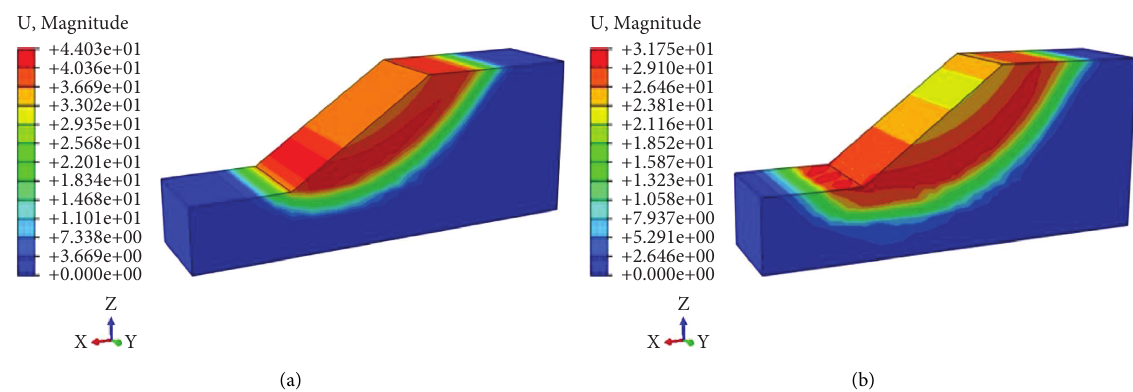
Figure 12: Slope displacement cloud map. (a) Before slope protection; (b) after planting plants.